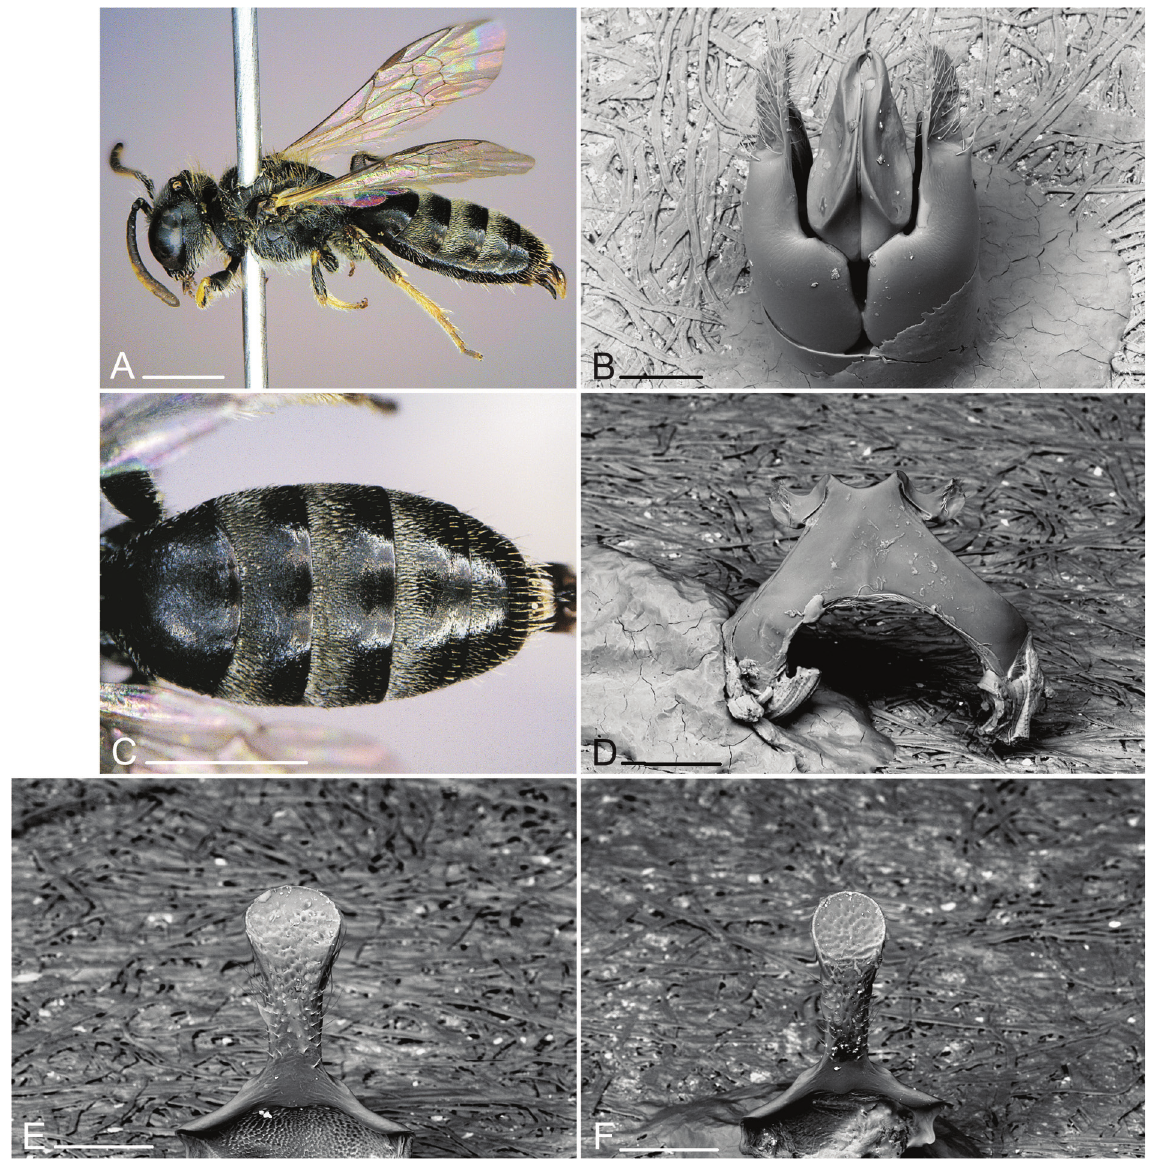
Fig. 5. Scrapter albitarsis (Friese, 1909), ♂. A . Lateral view. B . Genitalia (dorsal view, SEM). C . Metasoma (dorsal view). D . S7 (dorsal view, SEM). E . S8, apical end (SEM). F . S8, apical end (SEM). Scale bars: photos: 1 mm, SEM: